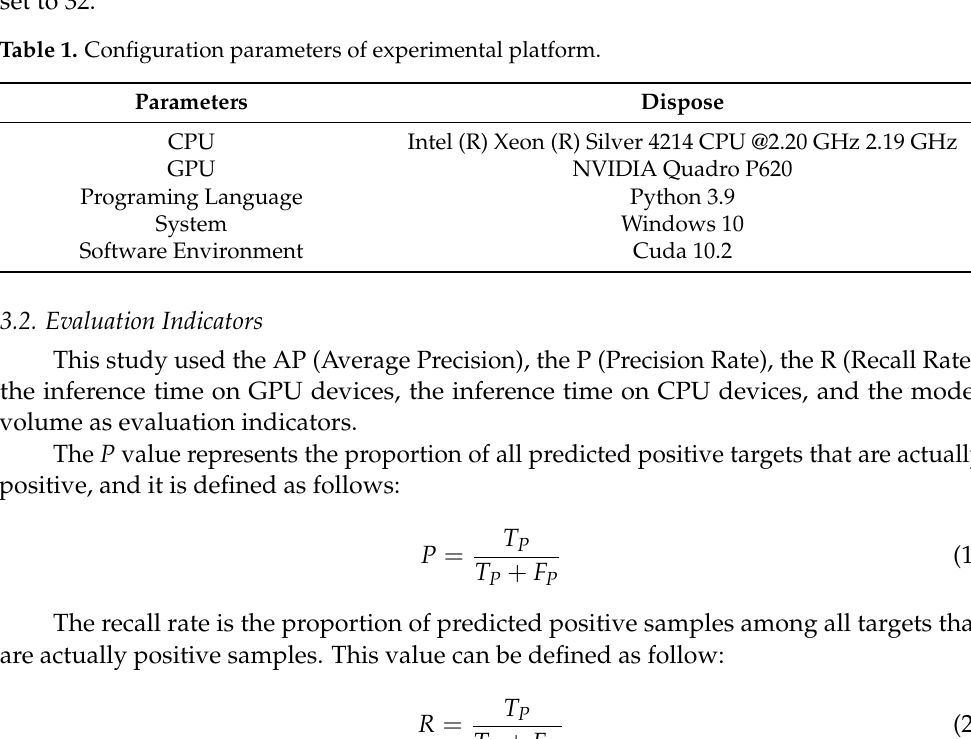
YOLOv5s algorithm. The neck network of YOLOv5-1, YOLOv5-2, YOLOv5-3, YOLOv5-4, YOLOv5-5, and YOLOv5-6 used the GhostConv module and C3 ghost module to